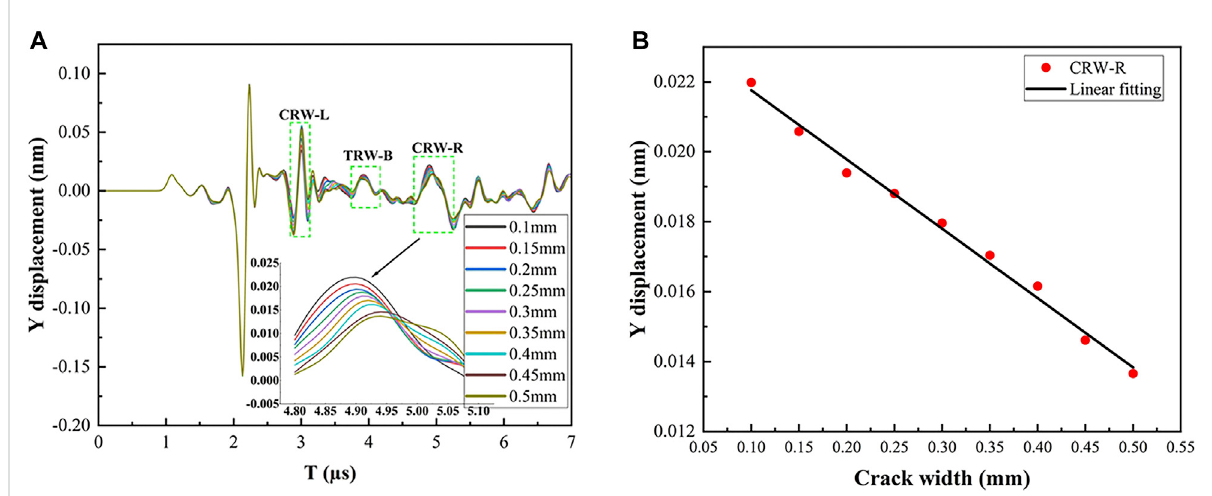
FIGURE 11 Y displacement and Fitting curve: (A) Different widths on the same side; (B) Fitting curve of CRW-R.